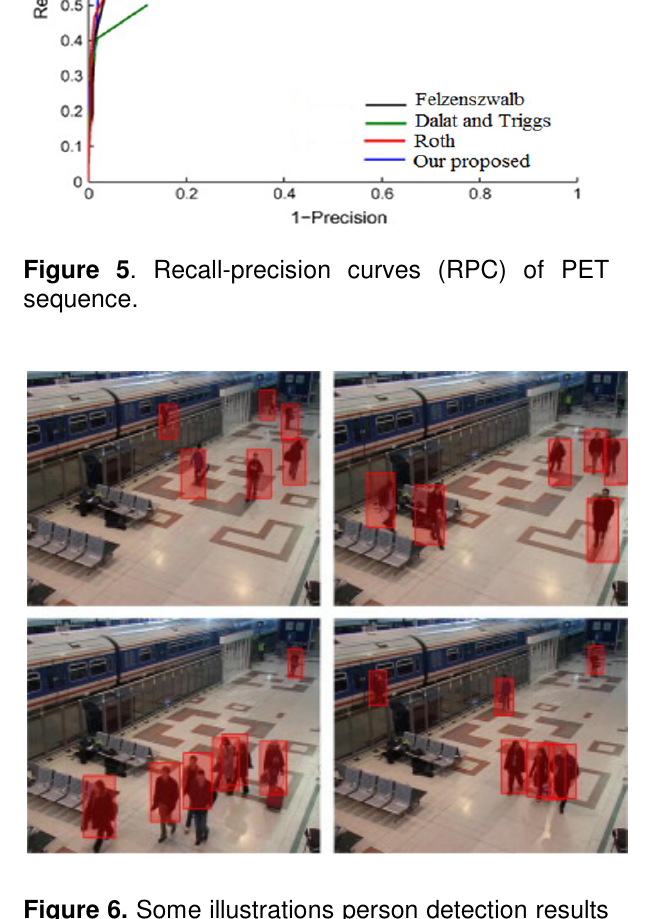
Figure 6. Some illustrations person detection results of the classifier grids for the PETdataset .